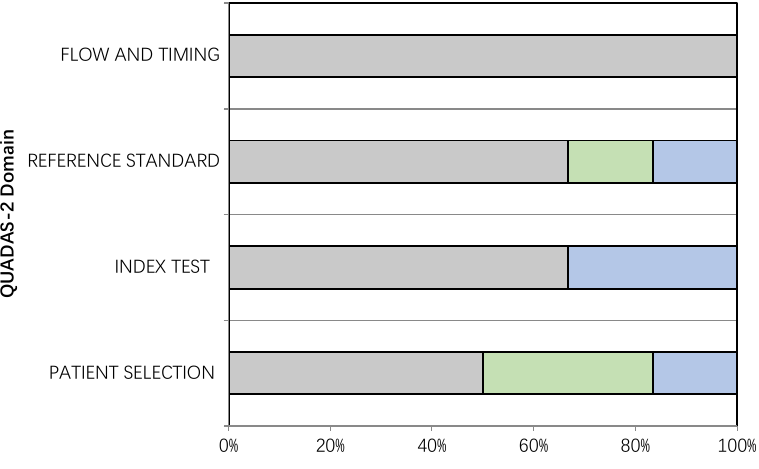
Table 3. Technical Details About CT Acquisition and ROI Tracing of the Included Studies.